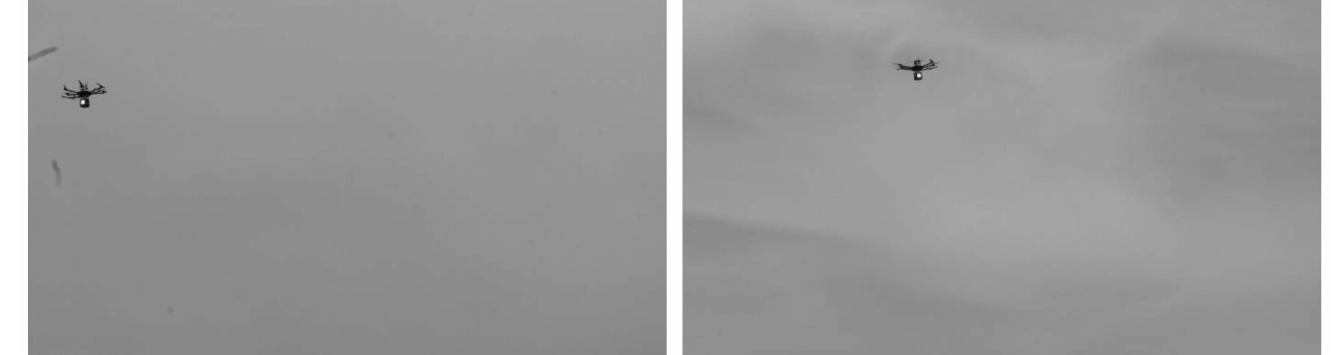
Figure 12. Real images captured in the pure sky by the left camera ( left ) and right camera ( right ). A total of 40 images were captured using the light source on the UAV as a 3D